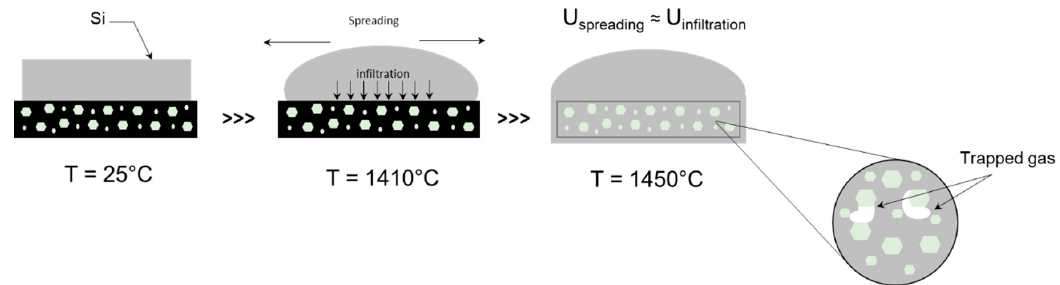
Figure 6. Schematic representation of the infiltration process in SiC p /C preforms under Ar flow.